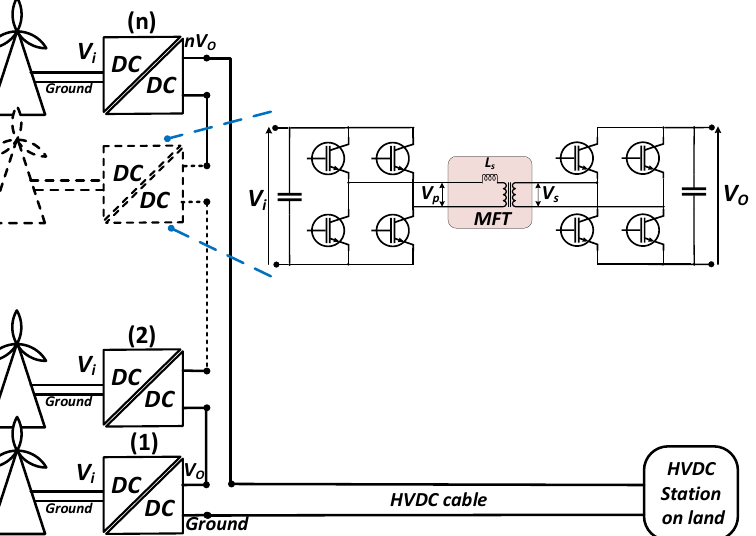
Figure 1. The series DC concept where the DC outputs of the wind turbines are directly delivering the high voltage to be transferred to land.